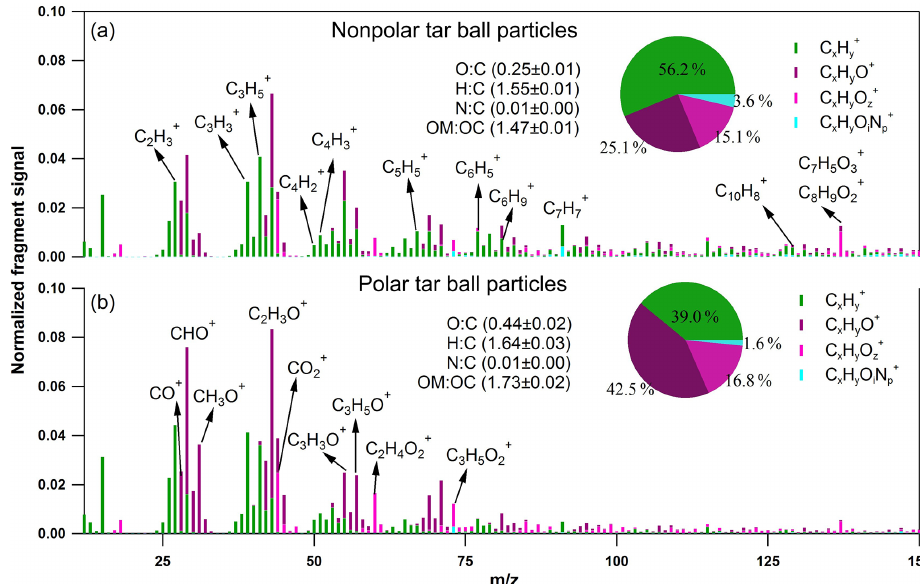
Figure 2. High-resolution AMS mass spectra of fresh polar and nonpolar tar ball particles. Four ion groups are grouped for clarity as C x H + y (green), C x H y O + (purple), C x H y O + z ( z> 1) (violet), and C x H y O i N + p (i0, p1) (light blue). The mass fractions of the four fragment groups are presented by pie